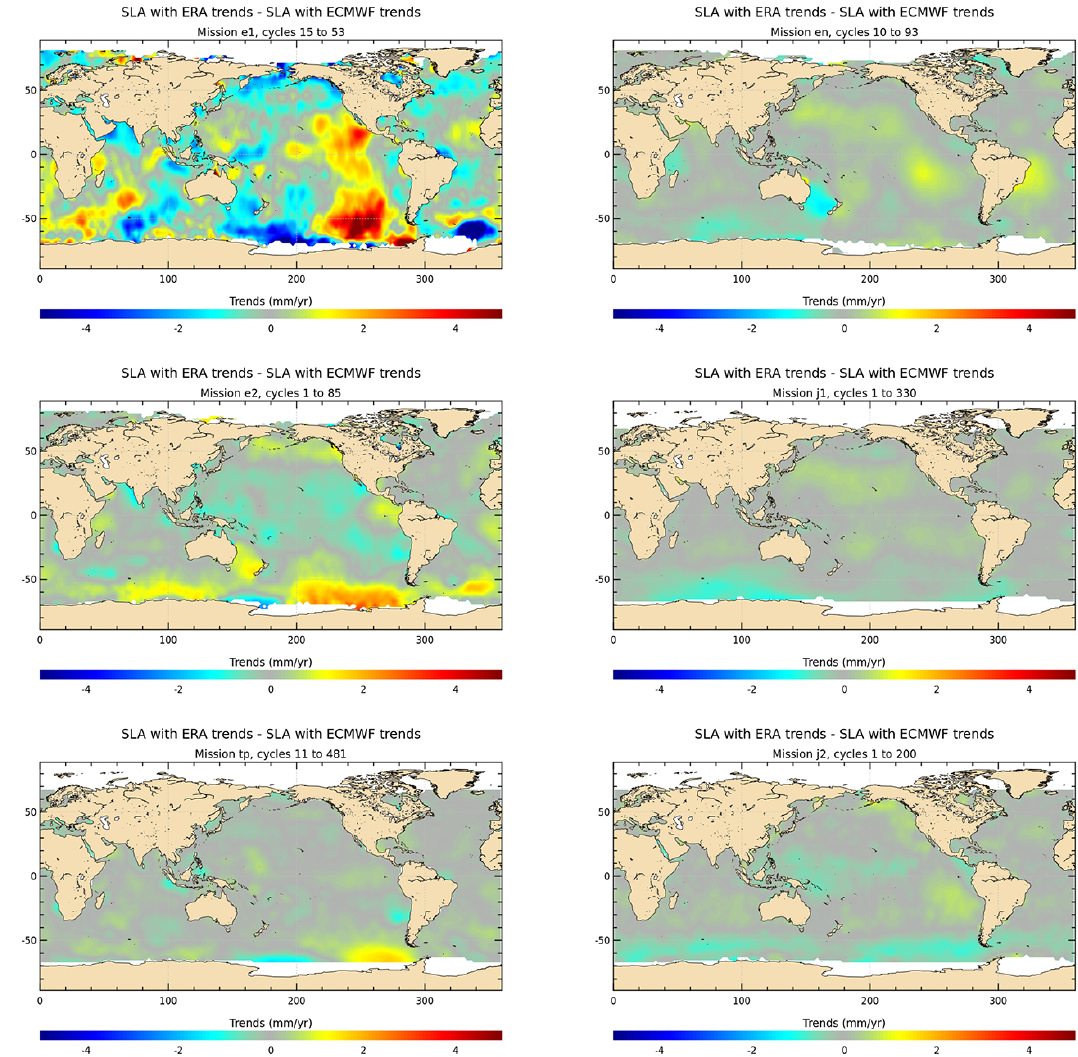
Figure 12. Maps of MSL trend differences successively using the DAC derived from ERA-Interim and from ECMWF operational pressures fields (reference) for ERS-1, ERS-2, and TOPEX (on the left), for Envisat, Jason-1, and Jason-2 (on the right) (mmyr − 1 ).